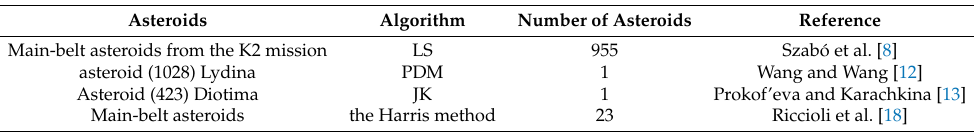
Table 1. Asteroids, algorithm, number of asteroids and reference of previous asteroid period calcula- tion